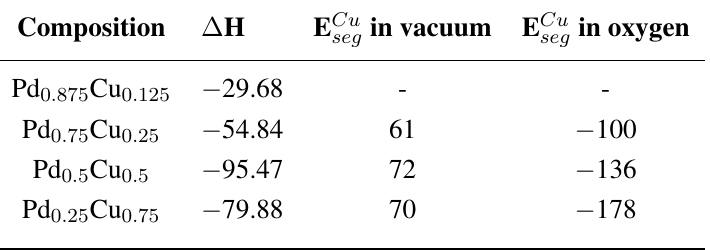
Table 1. Formation enthalpy ∆ H (meV/atom) and surface segregation energy of (meV). Cu E Cu seg